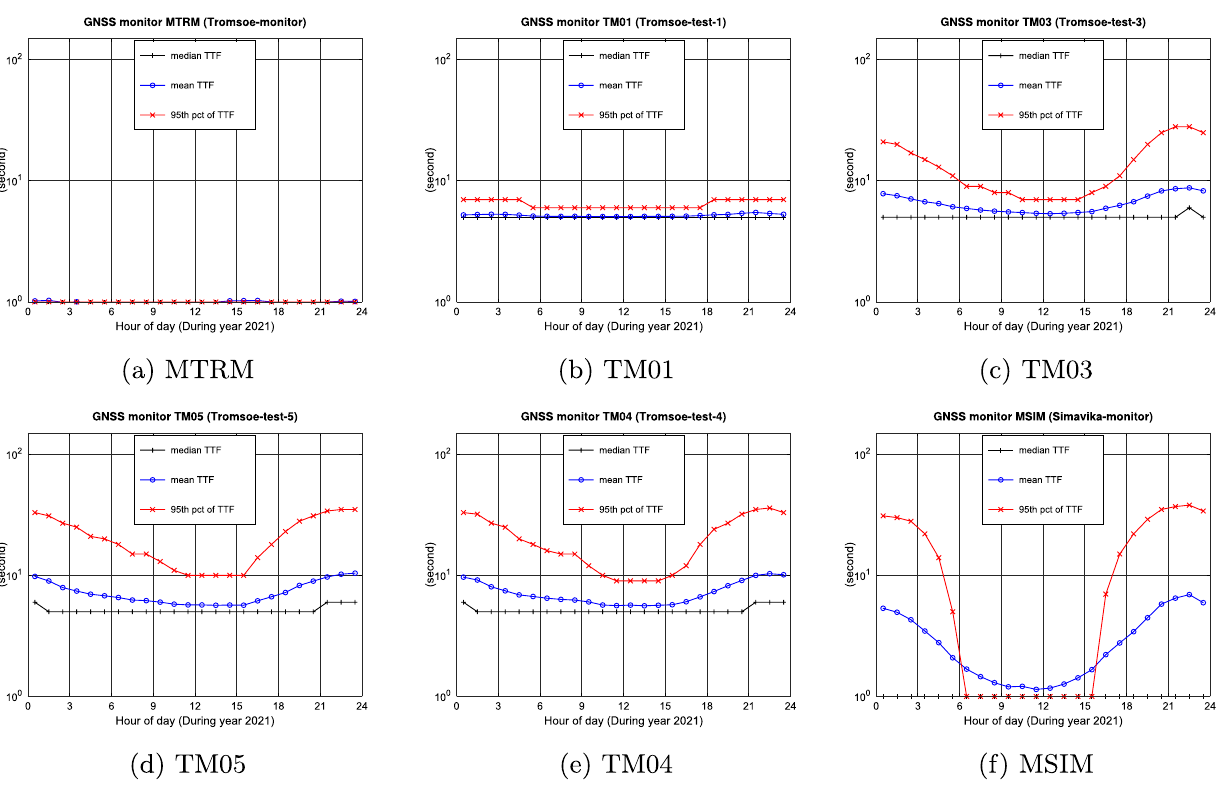
Fig. 8 Statistics as a function of time-of-day, in a subplot for each monitor receiver. The plots shows the median, mean and 95th percentile of the time-to-fix